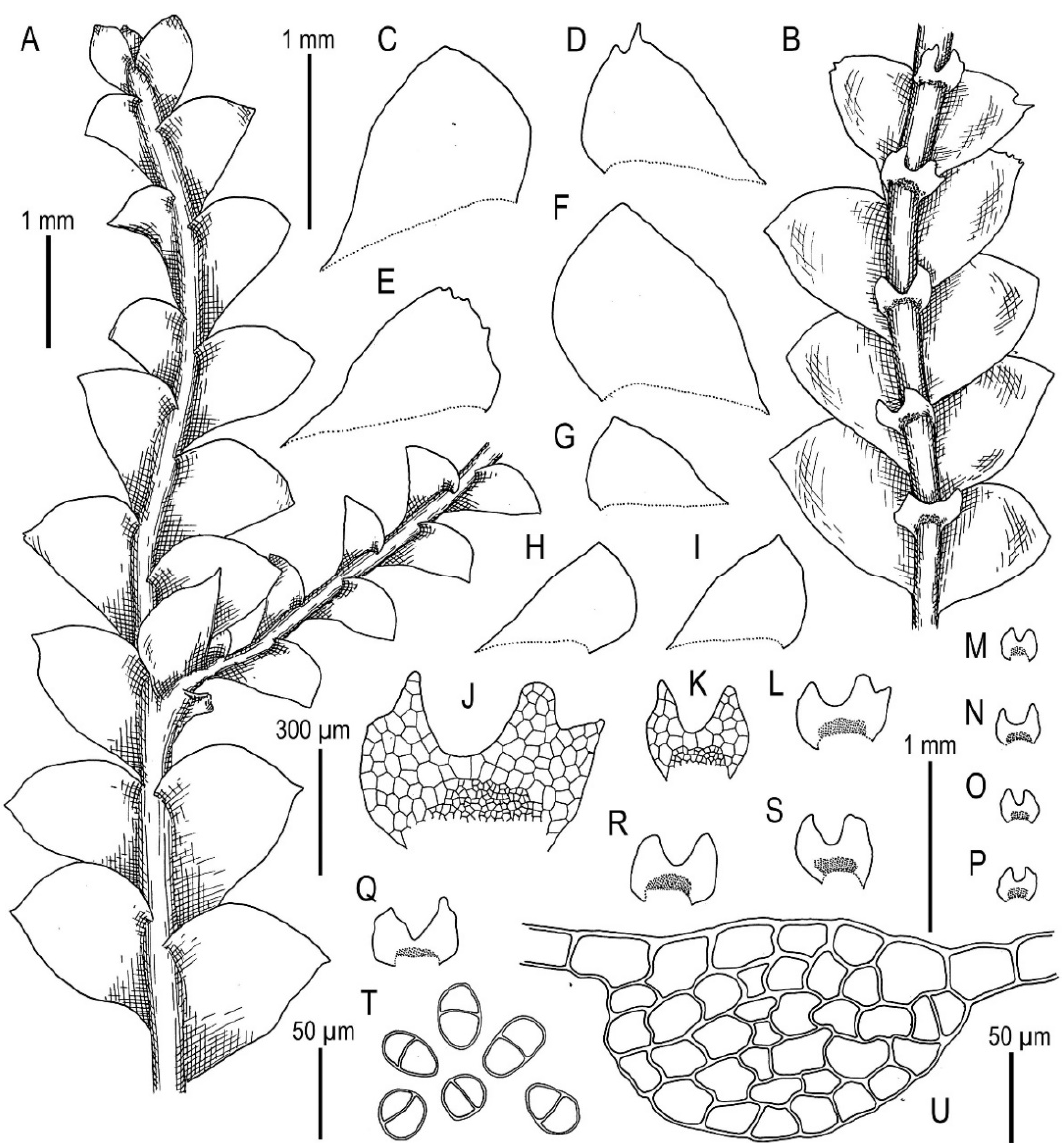
Figure 23. Calypogeia shevockii Bakalin et Troizk., sp. nov. : ( A ) Plant habit, fragment, dorsal view; ( B ) Plant habit, fragment, ventral view; ( C – I ) Leaves; ( J – S ) Underleaves; ( T ) Gemmae; ( U ) Stem cross section. All from Shevock 50287 (CAS, under Calypogeia fissa ; duplicate in VBGI). Other specimen examined (paratype): Russia, Russian Far East, Sakhalin Province, Sakhalin Island, Korsakovsky District, Bol (cid:48) shoe Vavayskoe Lake south-east vicinity (46 ◦ 34 (cid:48) 38.7 (cid:48)(cid:48) N 143 ◦ 18 (cid:48) 32.8 (cid:48)(cid:48) E), 6–10 m a.s.l., Picea glehnii forest in the plain, mesic de- caying wood in part shade, 27 September 2016, V.A. Bakalin, S-43-6-16 (VBGI). Comment. This species is probably one of the most common taxa of the genus in the southern part of the Russian Far East (Primorsky Territory, Sakhalin Island, South Kurils) and was previously misidentified as C. integristipula . C. pseudointegristipula differs from C. integristipula in its (1) distinctly emarginate to divided underleaves and (2) distinct trigones in the leaf cells, commonly distinct thickened cell walls along the leaf margin and commonly fine verruculose cuticle. Here, we limited the list of specimens examined to those specimens used for molecular analysis, although the distribution of the taxa is likely much